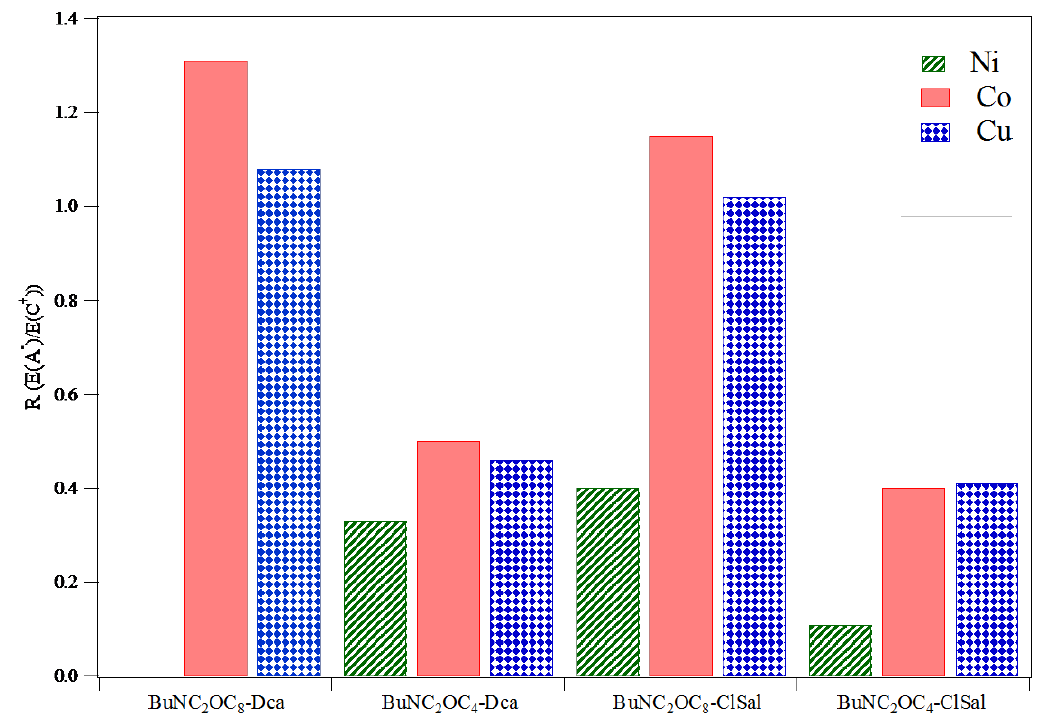
Figure 7. Ratio (A − /C + ) between the extraction rate of anion and those of Cu(II), Co.(II) and Ni(II), for the different salt used at different concentration.